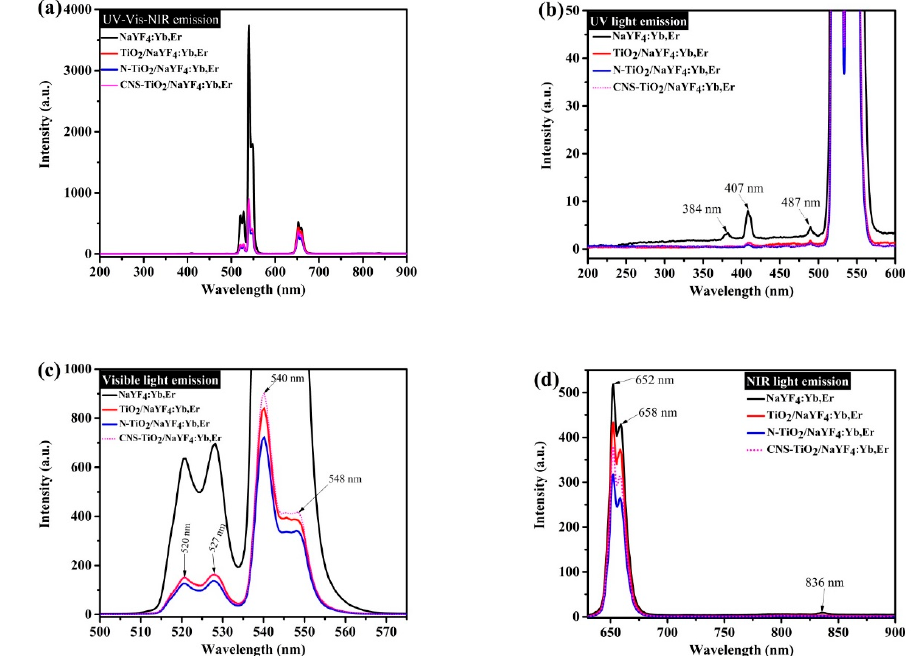
Figure 5. Photoluminescence spectra of NaYF 4 :Yb,Er coated with TiO 2 , N-TiO 2 and CNS-TiO 2 . ( a ) UV-Vis–NIR emissions and the enlarged spectra for ( b ) UV light, ( c ) visible light, and ( d ) NIR light emissions.